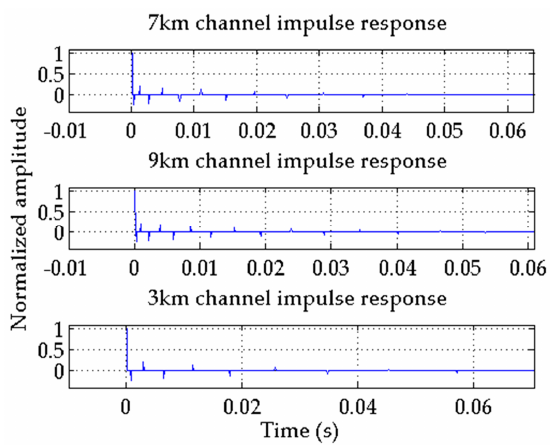
Figure 5. Channel impulse responses.